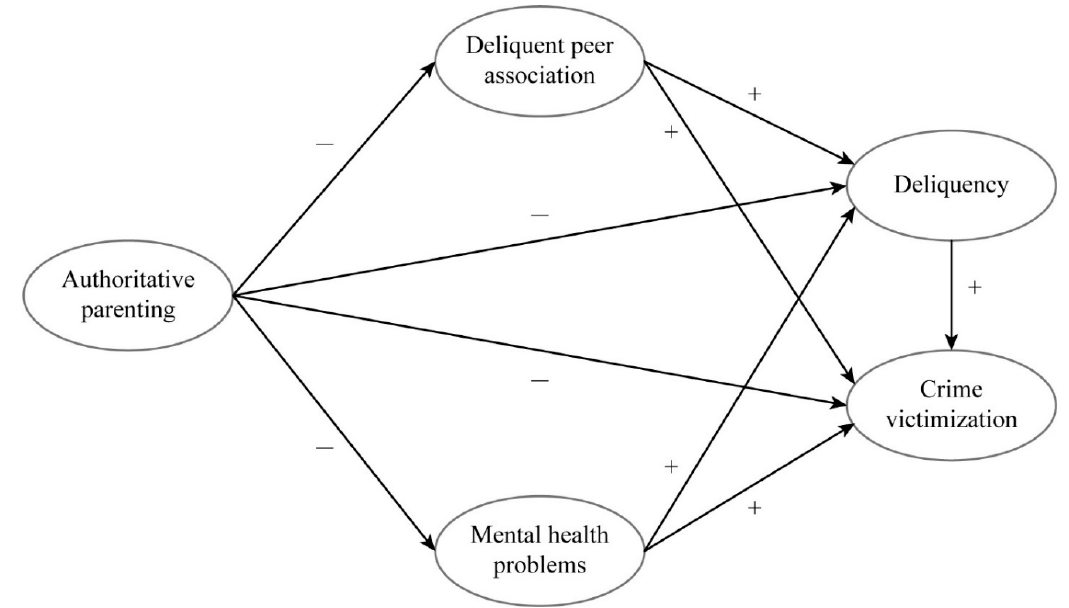
Figure 1. Theoretical Framework.